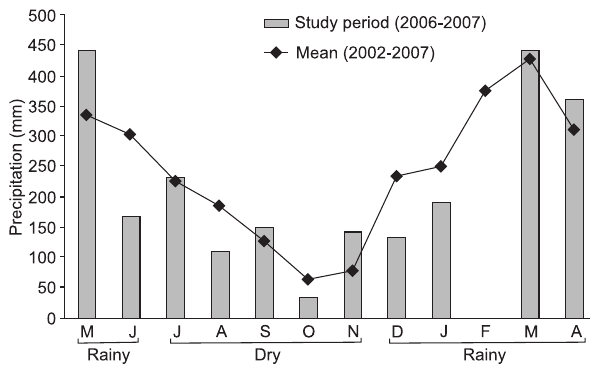
Figure 2. Monthly precipitation recorded at the Guajará Bay, Pará, Brazil, during the study period (2006-2007) compared with the mean values for the preceding five-year period (2002-2007). Source: A NA (2007). No data are available for February 2007, due to technical problems.